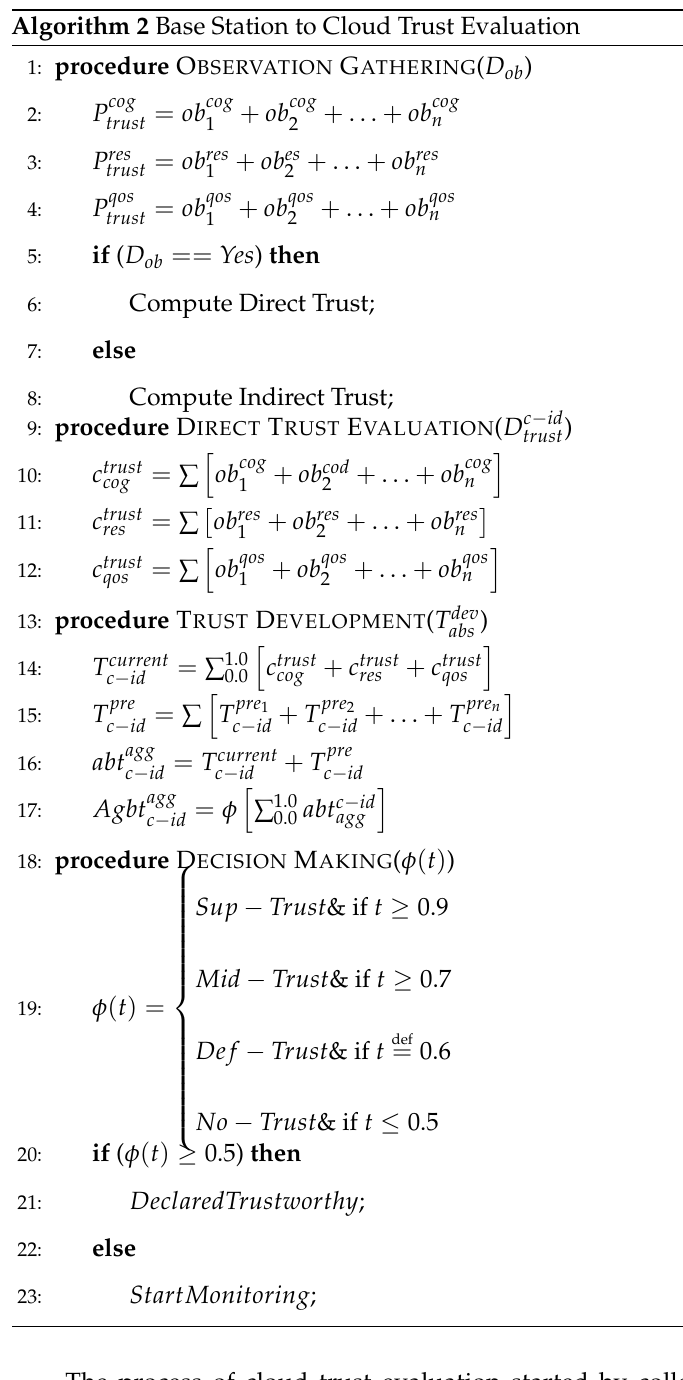
Algorithm 2 Base Station to Cloud Trust